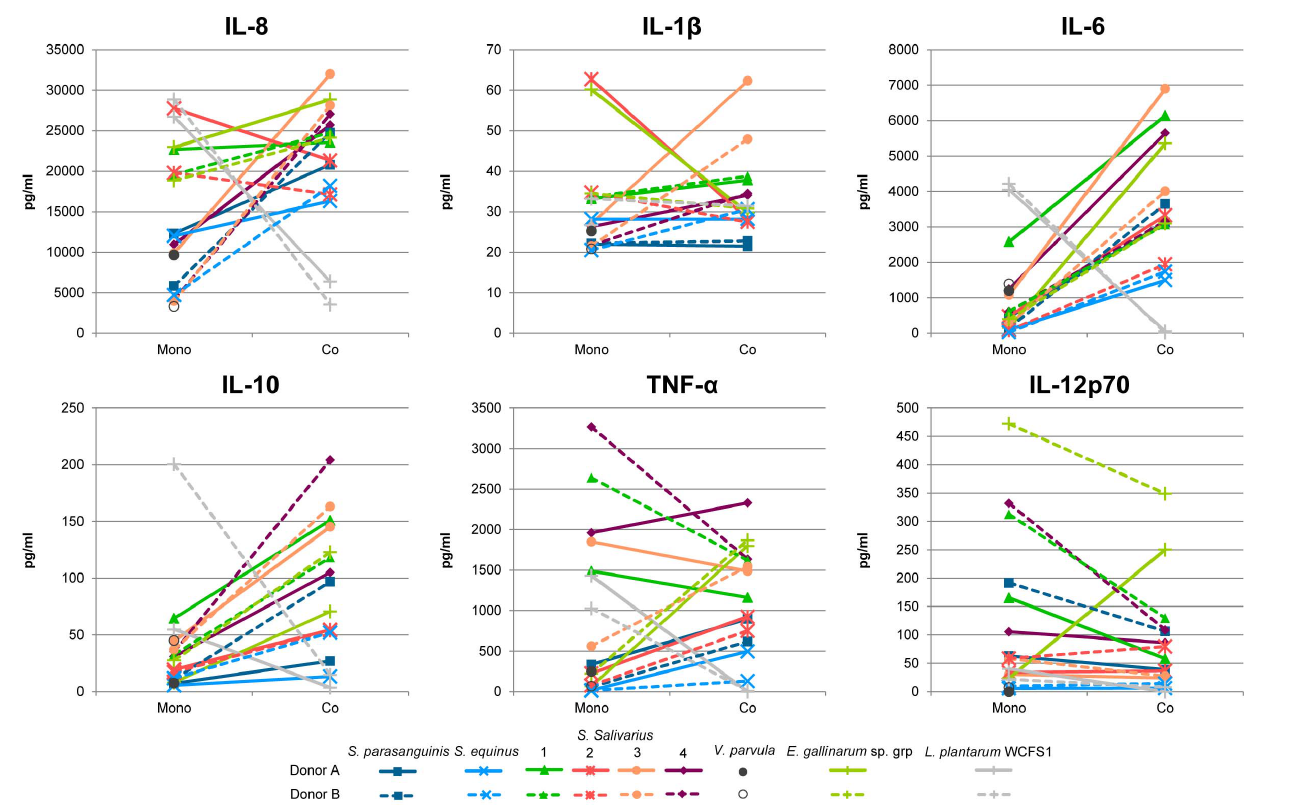
Figure 5. Cytokine secretion by dendritic cells after mono-stimulation with tested strains and co-stimulation with V. parvula . Dendritic cells were derived from 2 human donors. Mono-stimulations (Mono)_ and co-stimulations (Co) were both performed at a cell to bacteria, or a cell to a combination of two strains, ratio of approximately 1:10. See table S6 for cytokine